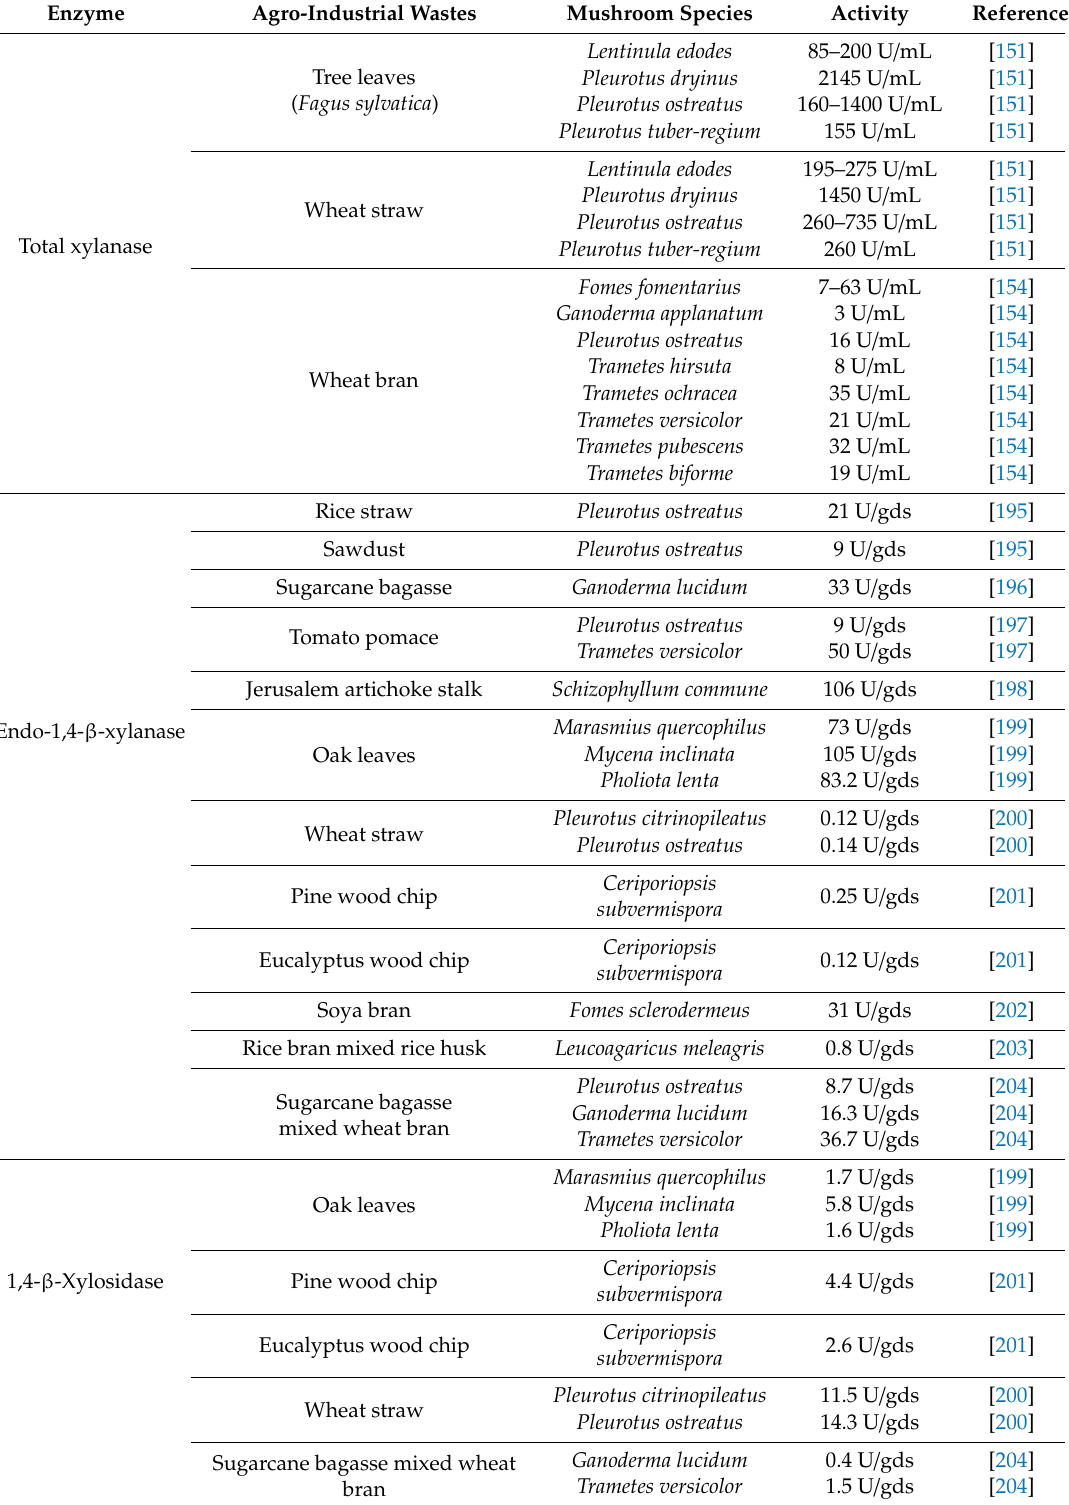
Table 6. Production of enzymes in solid state fermentation of hemicellulose degradation by some mushrooms using agro-industrial